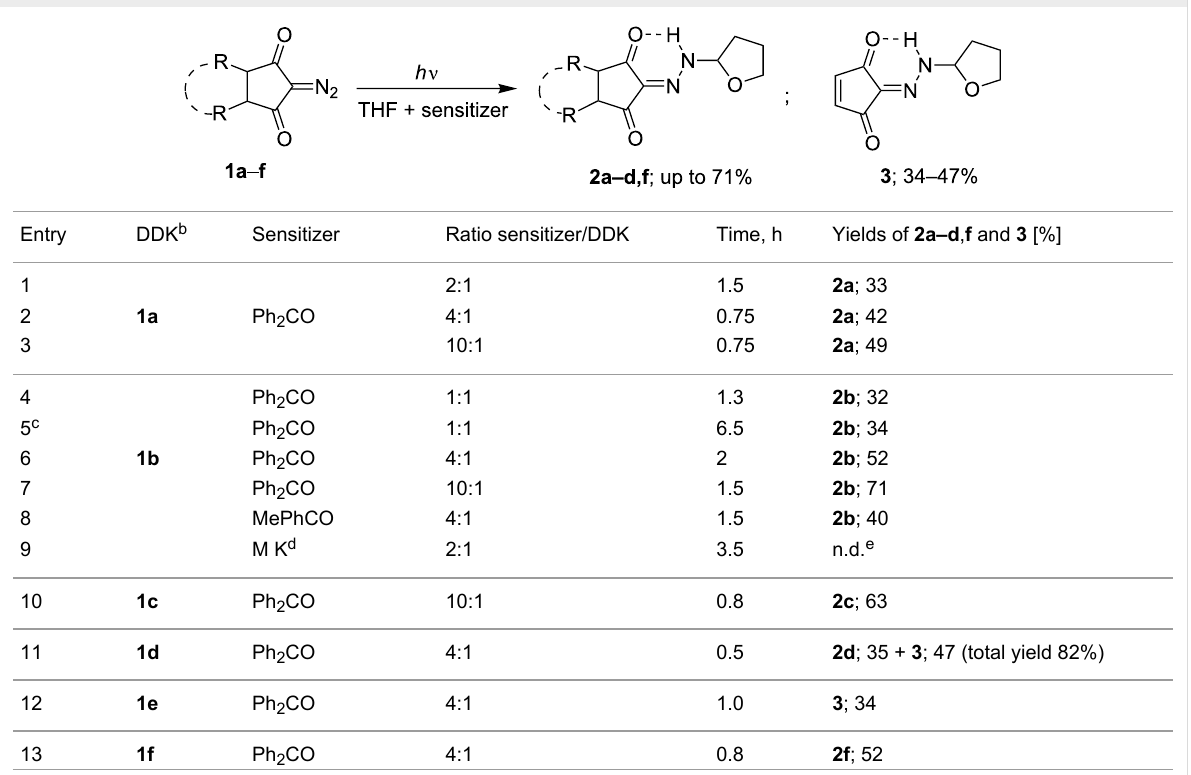
To increase the yields of hydrazones 2 , an effort was under- taken to optimize the photochemical reaction conditions by varying the wavelength of irradiation, sensitizer, as well as the ratio of sensitizer/diazodiketone 1b (Table 1, entries